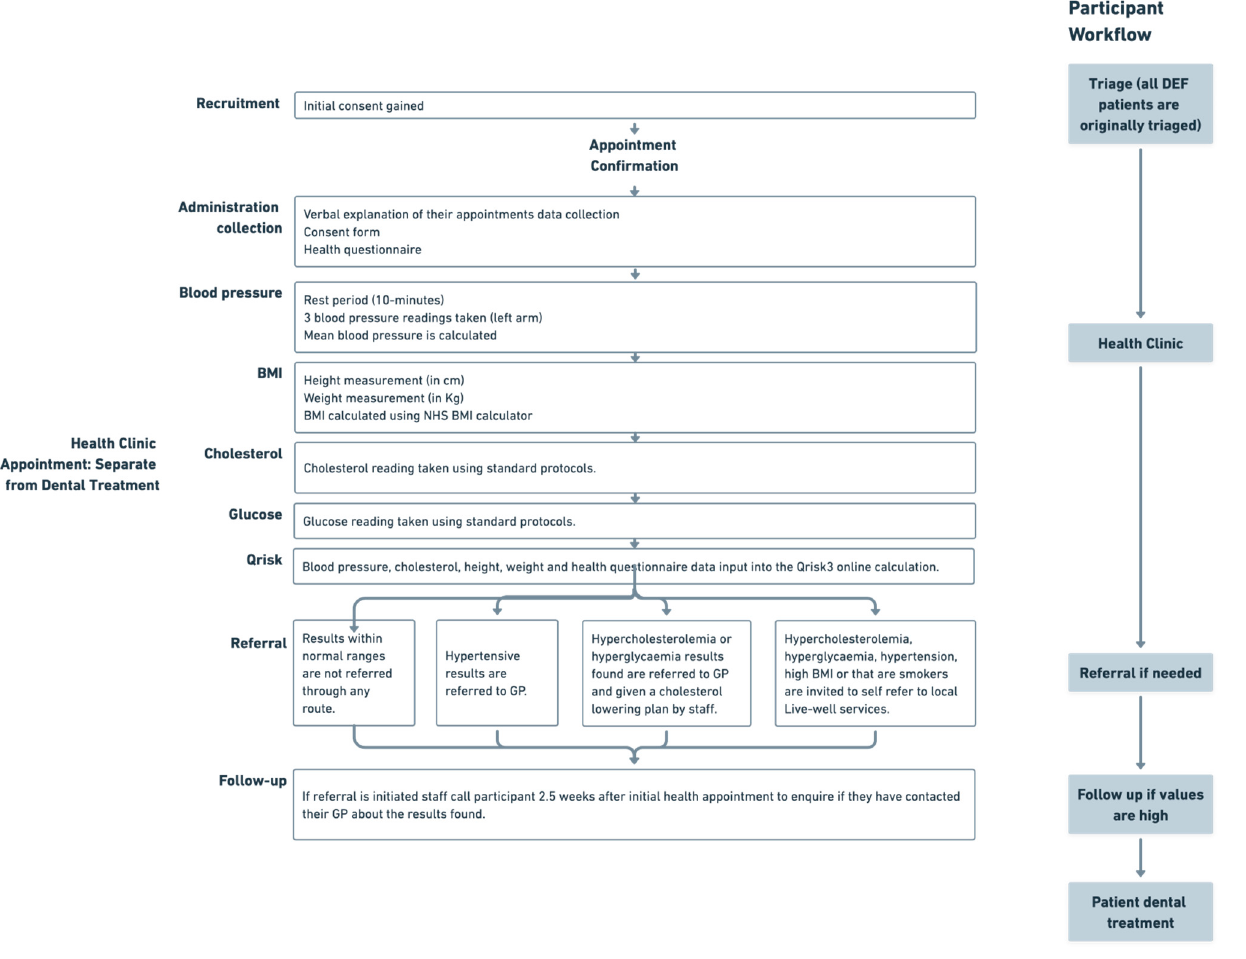
Figure 2. Applied workflow method for cardiovascular risk case-finding within a dental school, including a referral and follow-up pathway. DEF—dental education facility, GP—general practitioner, BMI—body mass